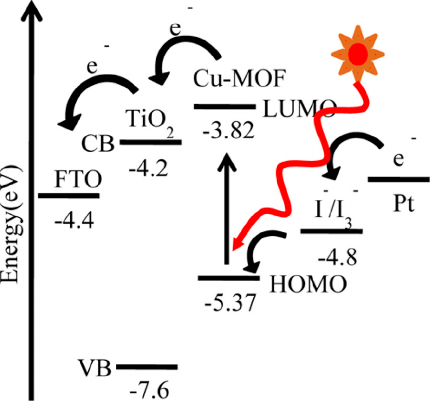
Figure 6. Energy diagram of TiO 2 − MOF system showing the suitable energy cascade for unidirectional flow of charge carriers. Reproduced with permission from [126] .